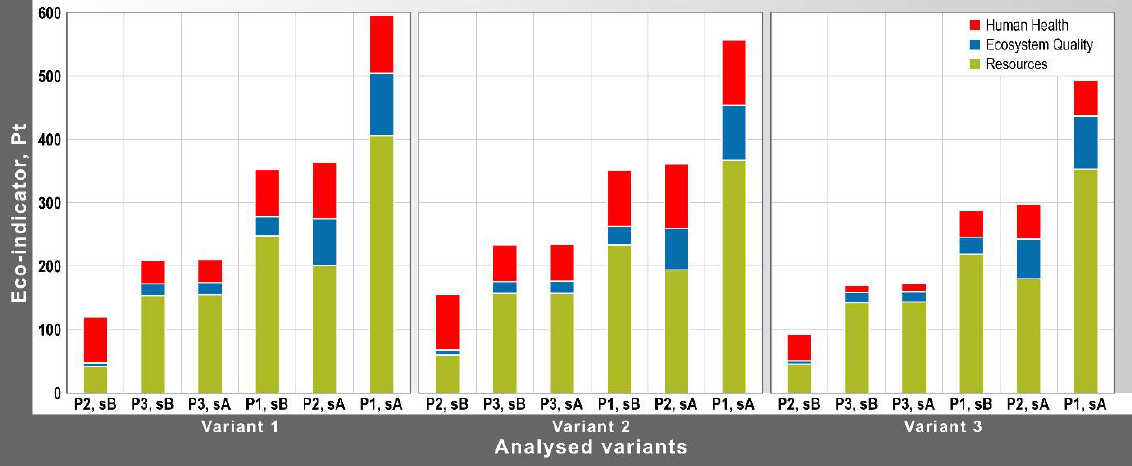
Figure 5. Eco-indicator results for the considered variants. Table 4. Values of Pt for the analyzed damage categories and the final value of Pt for the variants